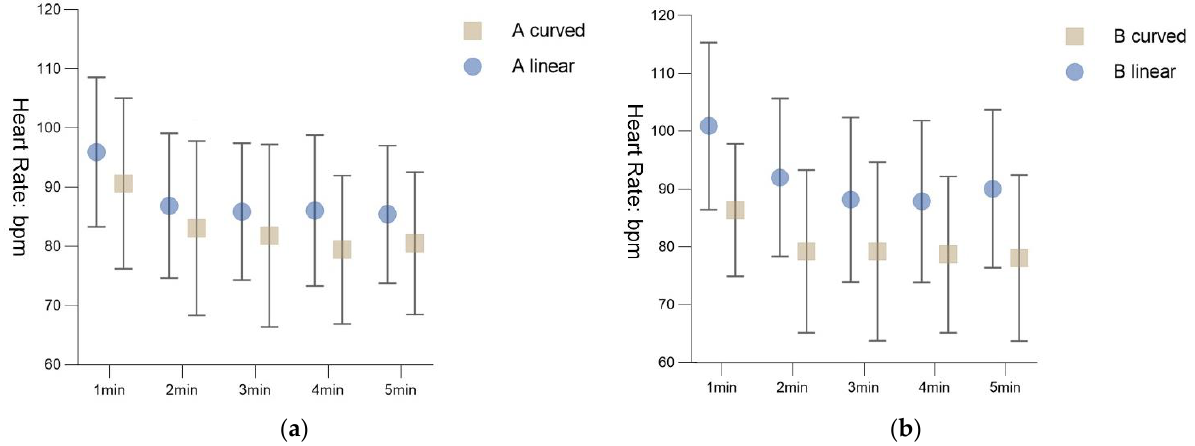
Figure 11. Mean and standard deviation of heart rate per minute: ( a ) Scenario A; ( b ) Scenario